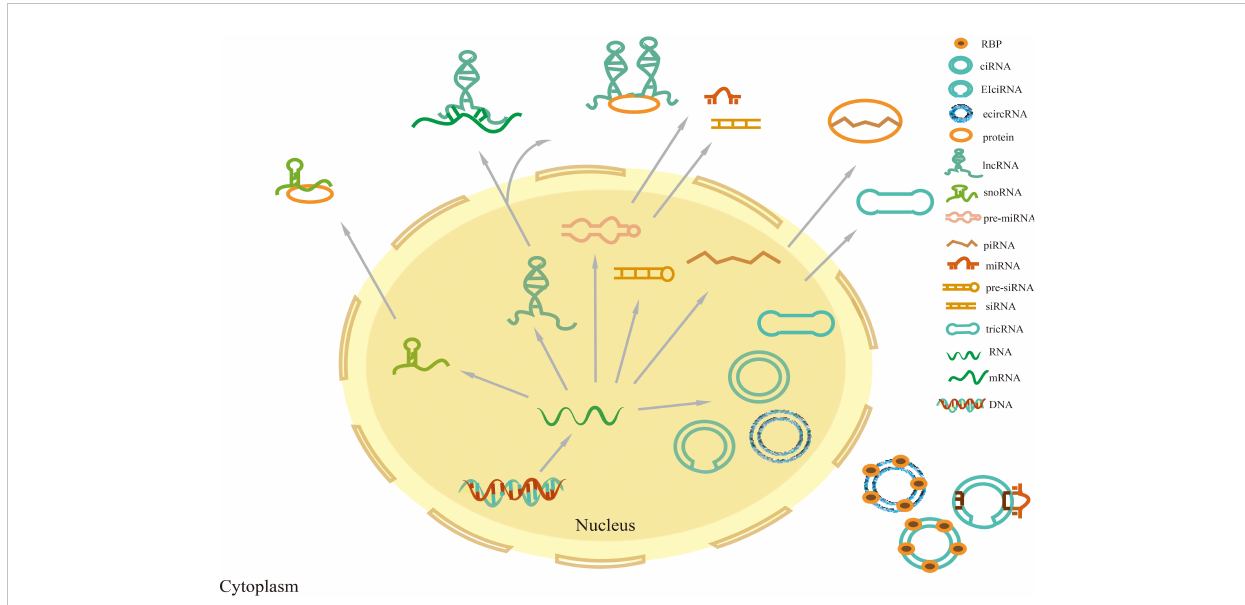
FIGURE 1 Classi fi cation of non-coding RNAs. Precursor miRNAs and siRNAs are transcribed and processed into mature miRNAs and siRNAs, respectively, which exert their function in the nucleus and cytoplasm. Precursor piRNAs are processed into mature piRNAs that form piRNA-PIWI complexes by combining them with PIWI proteins in the cytoplasm. TRNA intron splicing can lead to RNA cyclization, producing tricRNA. CircRNAs are divided into three main categories: intron-derived circular intronicRNAs (ciRNAs), exon-derived exonic circRNAs (ecircRNAs), and exon-intron circRNAs (EIcircRNAs). EIcircRNAs are mainly located in the nucleus, while ecircRNAs and tricRNAs are synthesized in the nucleus and will be exported to the cytoplasm. Most lncRNAs are located in the nucleus, and rarely encode proteins, while some are located in the